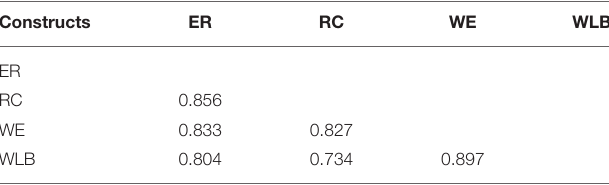
TABLE 3 | Discriminant validity using HTMT